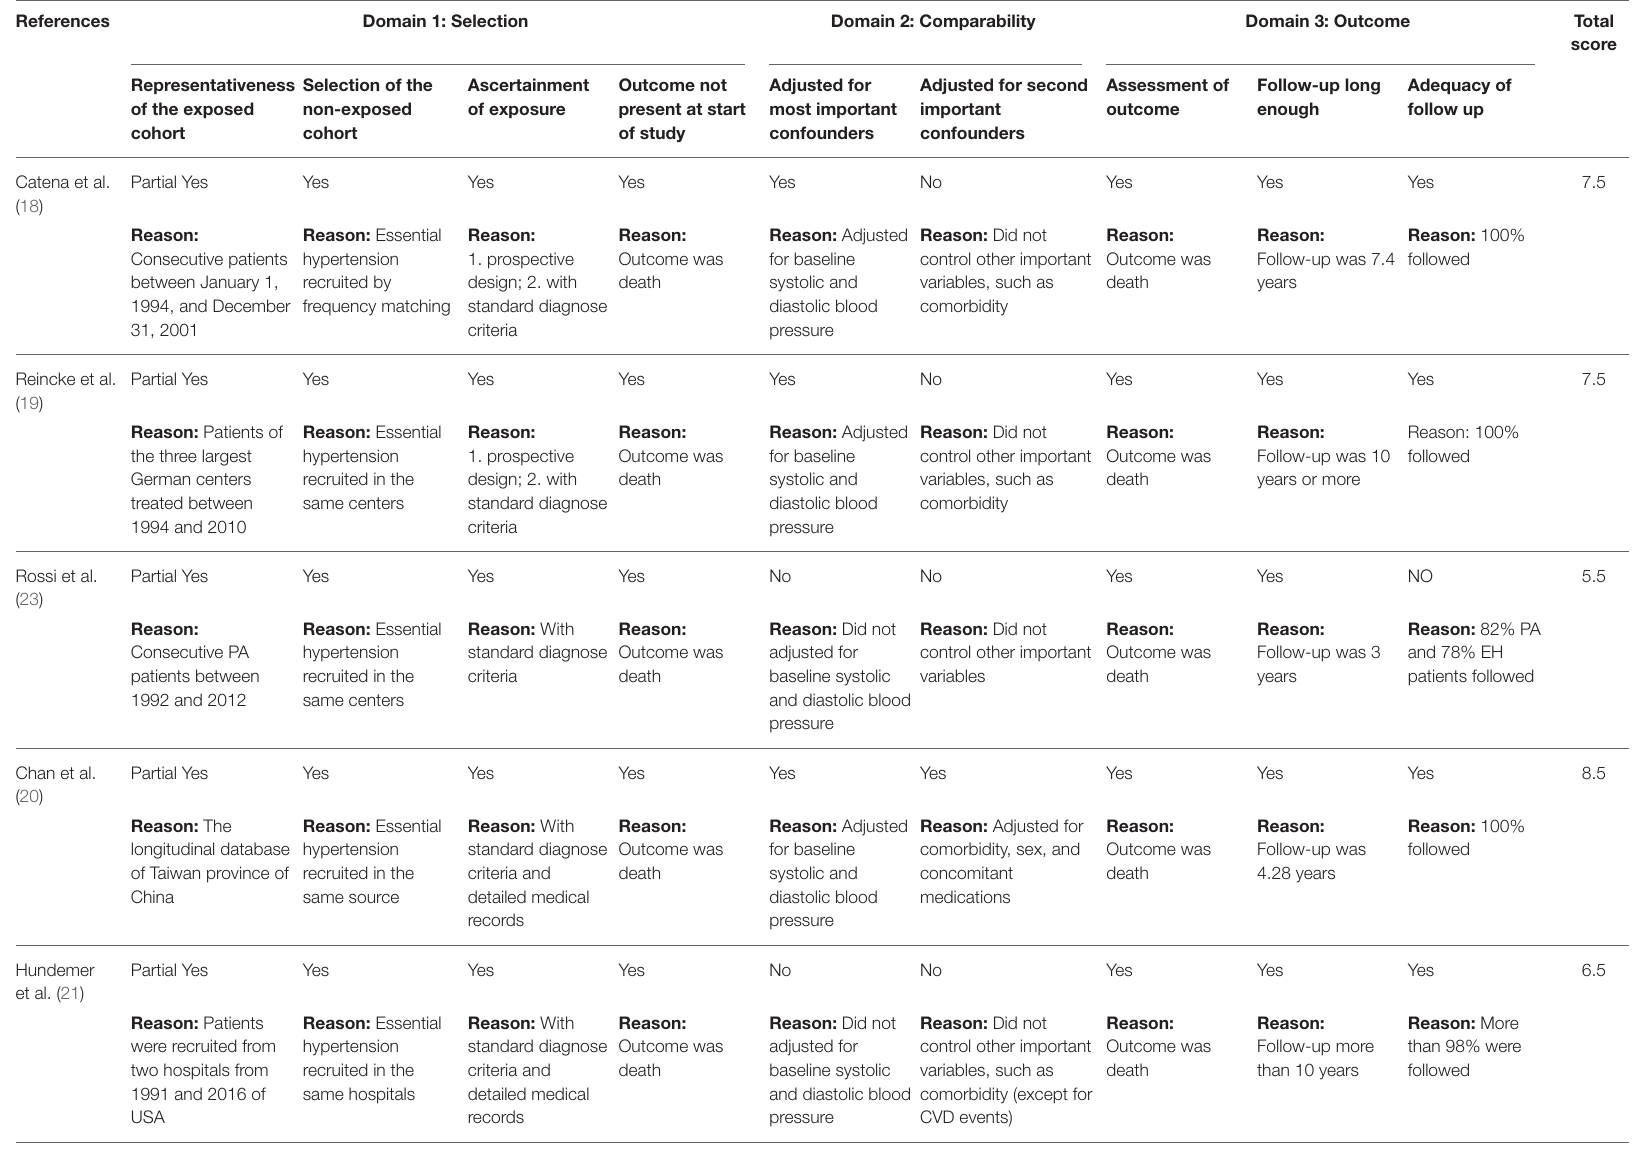
TABLE 2 | Quality